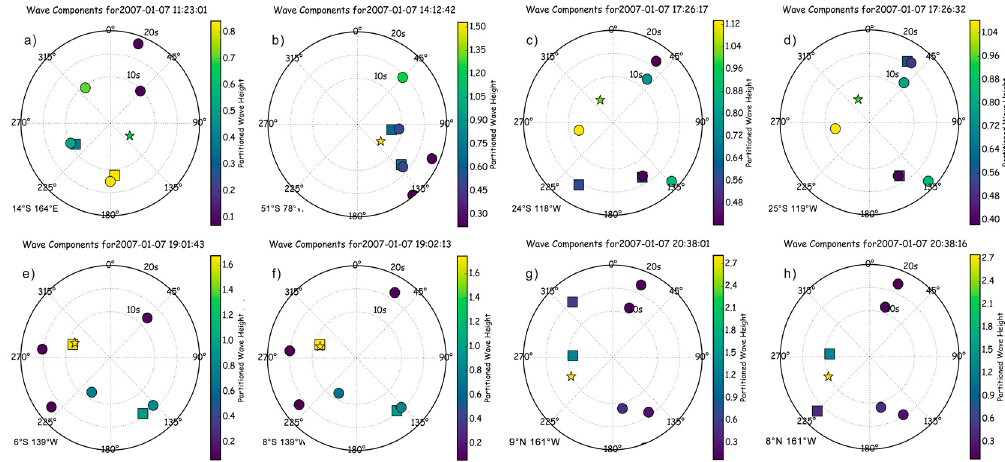
Figure 2. Some typical examples of WW3 data not in line with ASAR data on 7 January 2007: ( a , b ) two examples of missing sampling of energetic swell components; ( c,d ) an example of 180° ambiguity from two successive records ; ( e , f ) an example of instability in retrieving wind-sea information from two successive records; ( g , h ) an example of bad-quality inversion from two successive records. The information is shown in a direction-period polar diagram with the color indicating the wave height. The circles represent the swell partitions from WW3. The squares represent the swell partitions from ASAR. The stars represent the wind-sea partitions from WW3.